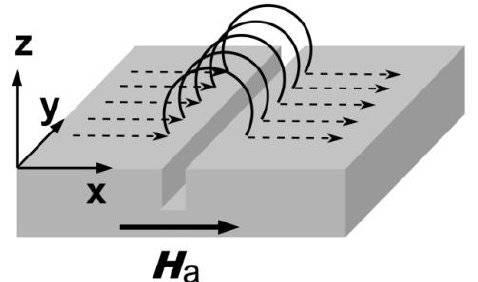
Figure 1. Scheme of the MFL of a crack. Surface breaking magnetic field lines in the presence of